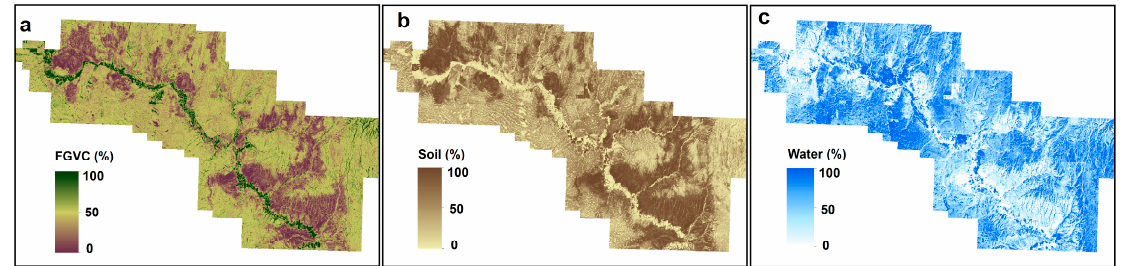
Figure 7. An example spectral unmixing results from the west block of Grasslands National Park (GNP) using Landsat image acquired from 15 July 2011. ( a – c ) are unmixed fractional green vegetation cover (FGVC), bare soil / litter, and water.